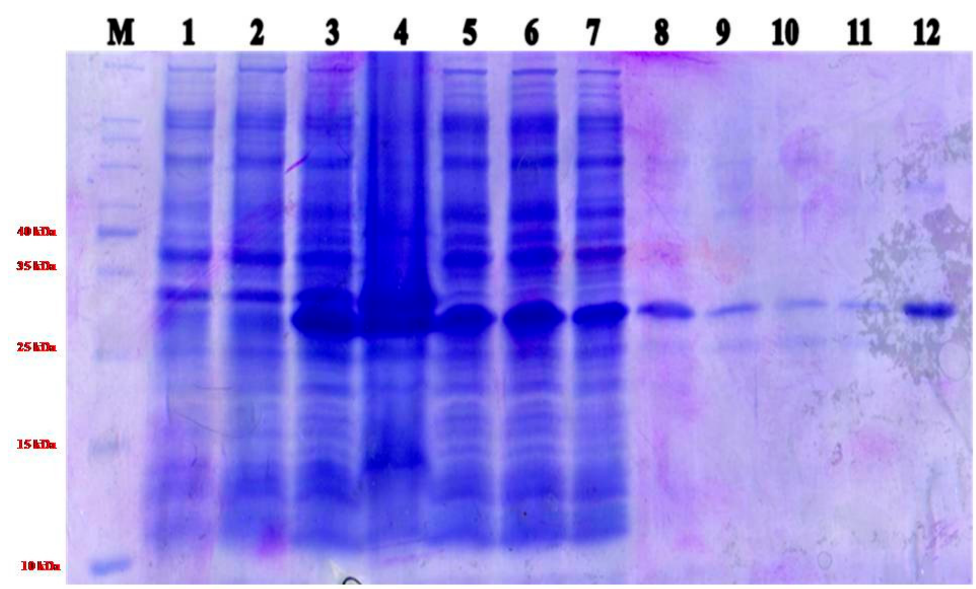
Figure 2. SDS-PAGE (14%) showing expression of recombinant ToLCNDV-Rg-CP in Escherichia coli under 0.3 mM IPTG and purification of recombinant ToLCNDV-Rg- CP using 0.5 % triton-X 100. Lanes M: Protein Marker; Lane 1: E. coli BL-21 cells; Lane 2: Uninduced, Lane 3: Whole cell lysate, Lane 4: Pellet, Lane 5: Supernatant, Lane 6: Flow through; Lane 7: Beads before wash; Lane 8: Beads after wash; Lane 9–11: Eluted protein; Lane 12: Concentrated